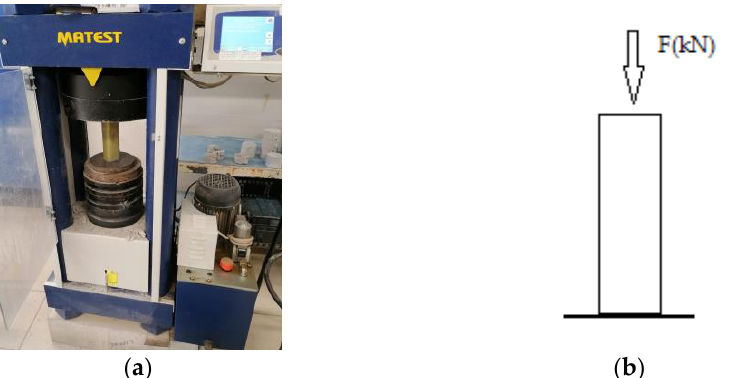
Figure 12. ( a ) MATEST TREVIOLO press of capacity 2000 kN during the compression tests; ( b ) representation of compression measurement.